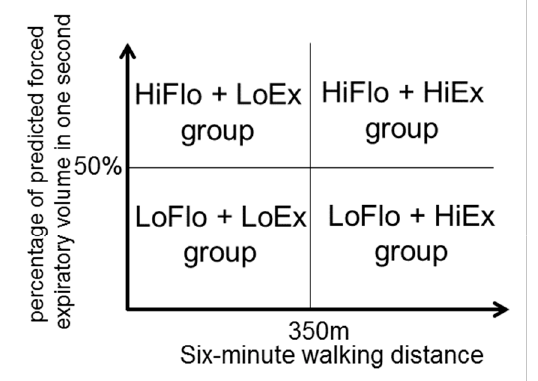
Figure 1. Classification of the LoFlo + HiEx, HiFlo + HiEx, LoFlo + LoEx, and HiFlo + LoEx groups. Participants with a 6MWD ≥ 350 m and %FEV 1.0 <50% were defined as the LoFlo + HiEx group, participants with 6MWD ≥ 350 m and %FEV 1.0 ≥ 50% as the high expiratory flow—high exercise capacity (HiFlo + HiEx) group, patients with 6MWD <350 m and %FEV 1.0 <50% as the low expiratory flow—low exercise capacity (LoFlo + LoEx) group, and patients with 6MWD <350 m and %FEV 1.0 ≥ 50% as the HiFlo + LoEx group.